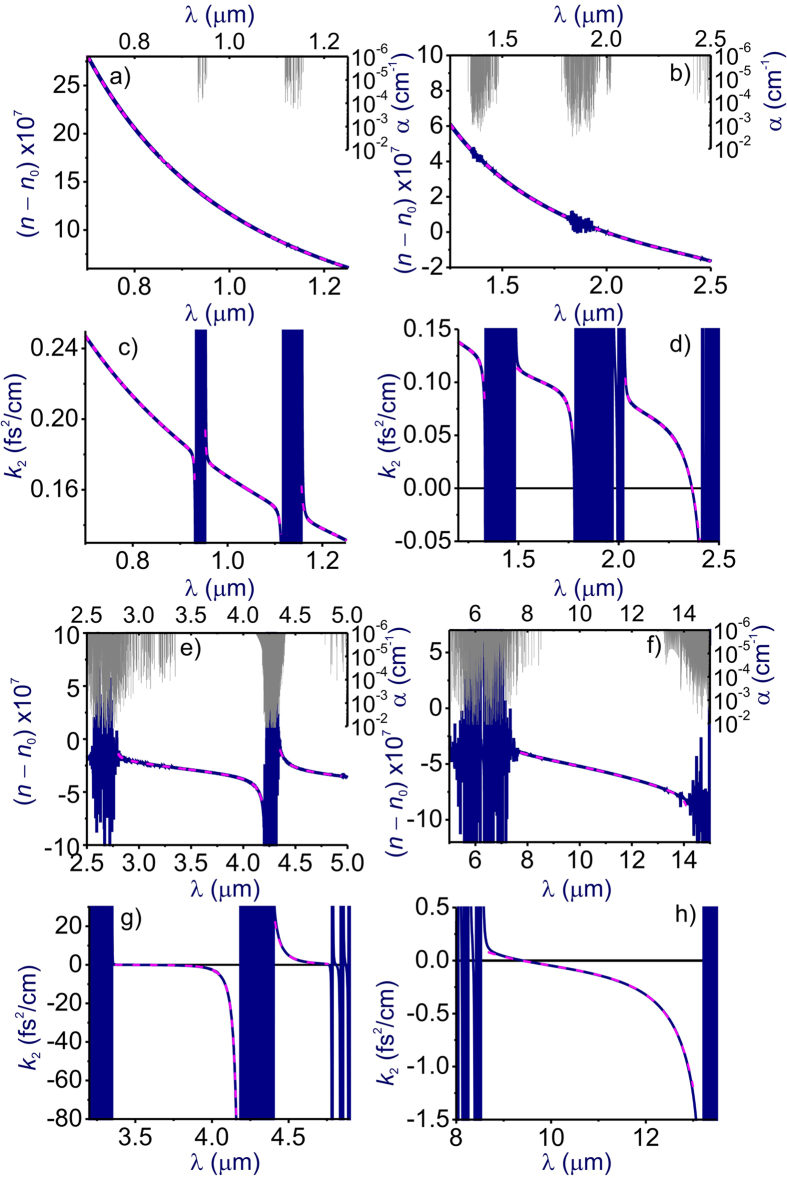
The refractive index (a–d) and the group-velocity dispersion (e–h) calculated as functions of the wavelength using the full model of air refractivity based on Eq. (1) including the HITRAN-database manifold of atomic and molecular transitions (blue line) and Eq. (5) including M = 15 terms with parameters as specified in Table 1 (pink line): (a,e) visible and near-IR, (b,f) near-IR, (c,g) mid-IR, and (d,h) mid-IR and LWIR ranges. Absorption spectrum of air is shown by grey shading. Atmospheric air is modeled as a mixture of molecular and atomic gases with densities NN2 = 1.987 ∙ 1019 cm−3, NO2 = 5.3291 ∙ 1018 cm−3, NAr = 2.3763 ∙ 1017 cm−3, NH2O = 7.0733 ∙ 1016 cm−3 (10% humidity), and NCO2 = 9.4136 ∙ 1015 cm−3. The temperature is 296 K, n0 = 1.000273.